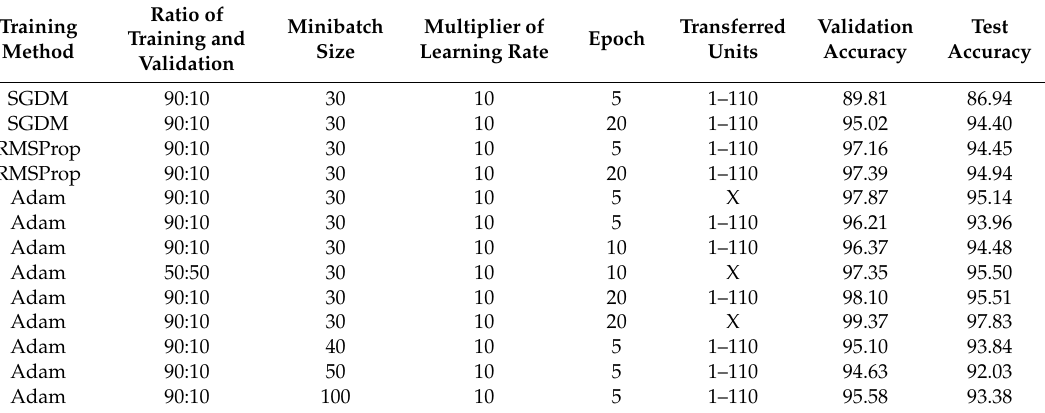
Table 3. Performance of googleNet on PTB-ECG.